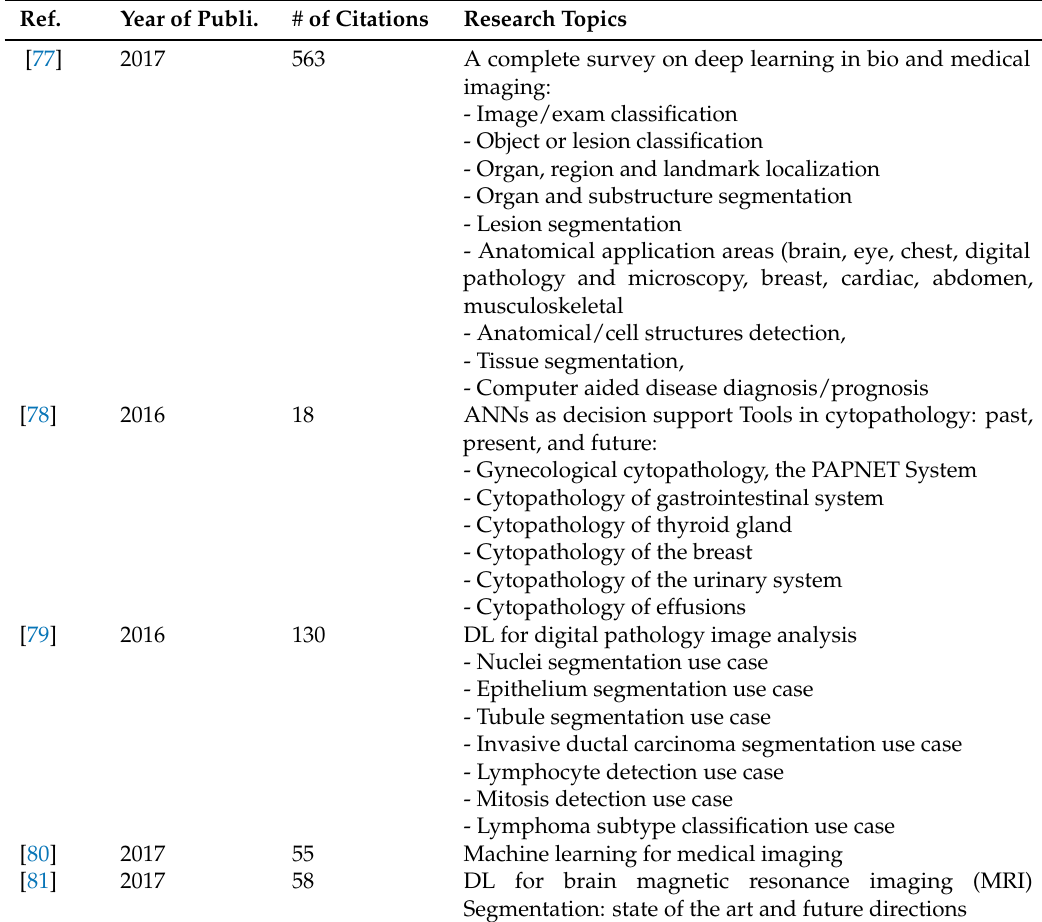
Table 2. Survey papers on Deep Learning in bio and medical imaging.